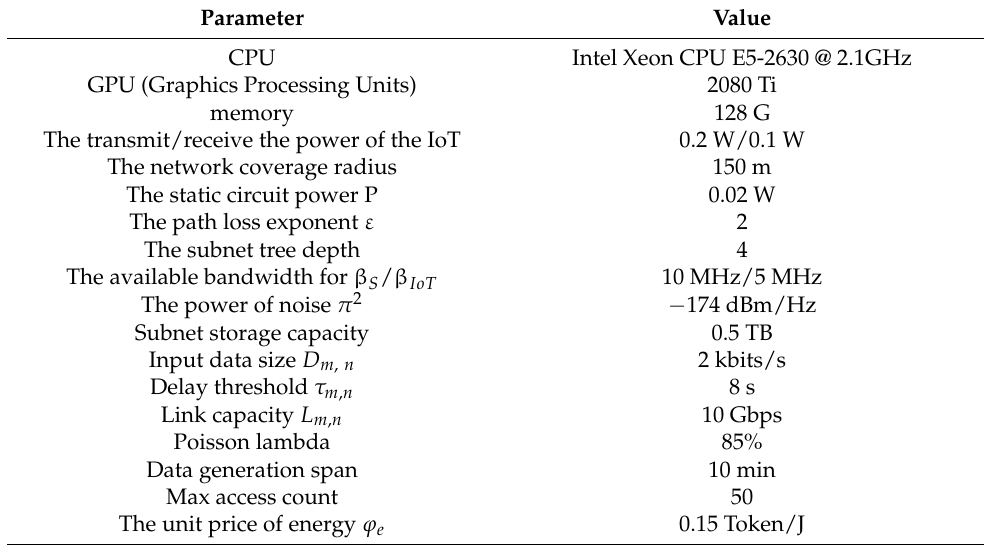
Table 2. Environment parameters.